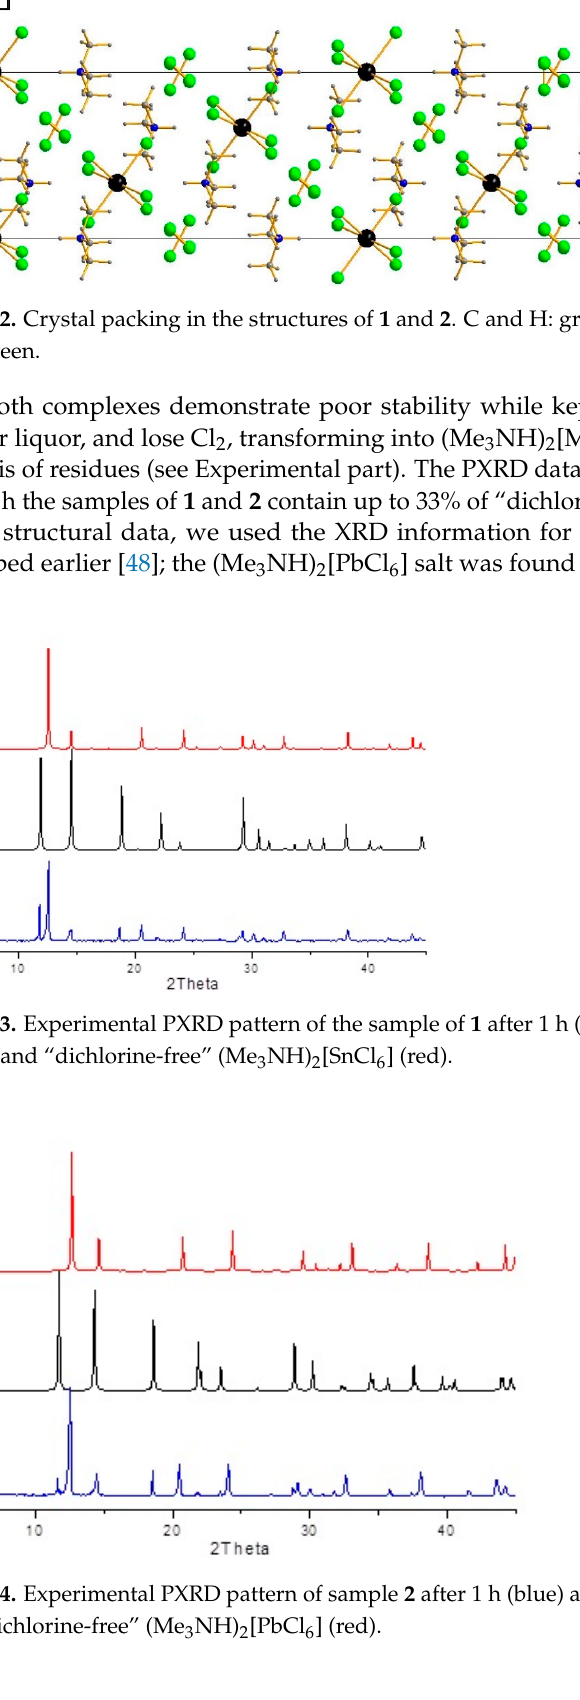
Figure 1. Cl···Cl interactions (dashed) in the structures of 1 and 2 . Metal: black, Cl: light green.